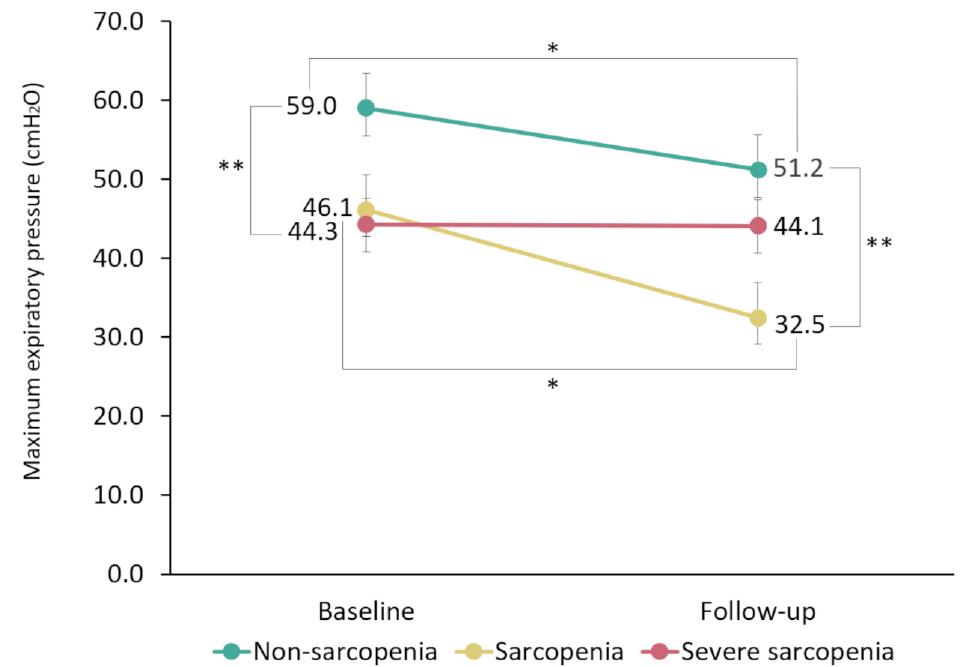
Figure 2. One-year changes in maximum expiratory pressure (MEP) in the non-sarcopenia, sarcopenia, and severe sarcopenia groups based on repeated two-way analysis of variance. Bars in the figure indicate the standard errors. MEP shows a significant interaction between the measurement time and severity of sarcopenia. Measurement time (baseline, follow-up) and severity of sarcopenia (non-sarcopenia, sarcopenia, severe sarcopenia) had significant main effects on MEP values. * Significant simple main effect of measurement time. ** Significant multiple comparison of sarcopenia severity (significant simple main effect observed at both baseline and follow-up).